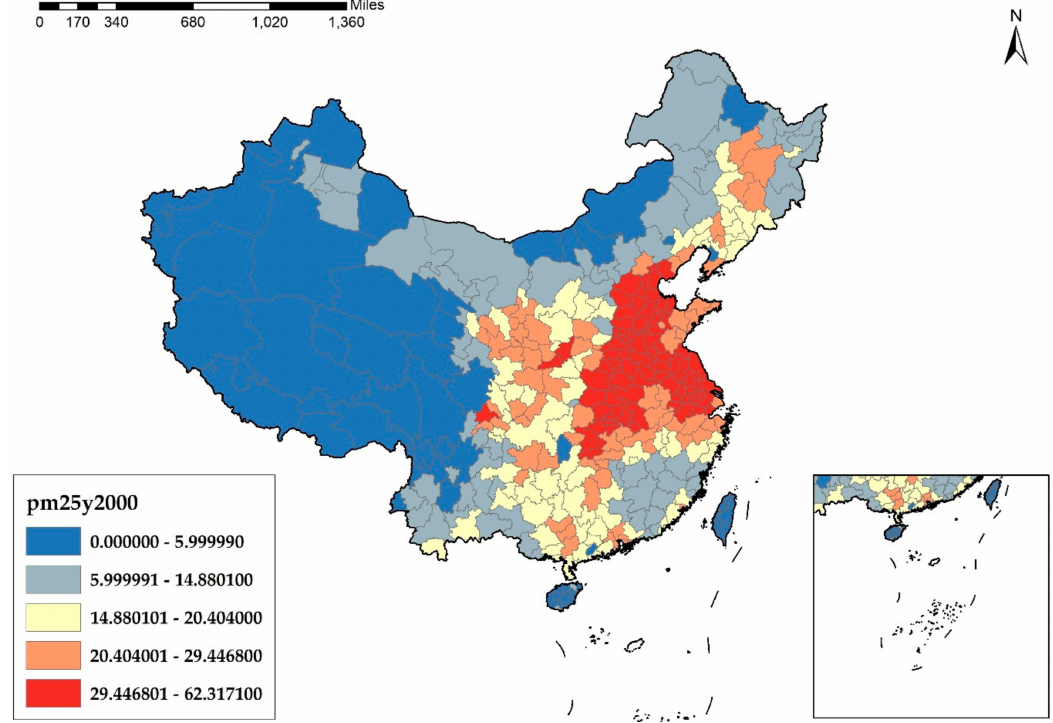
Figure 1. PM 2.5 Concentration at the city level in China in 2000 ( µ g / m 3